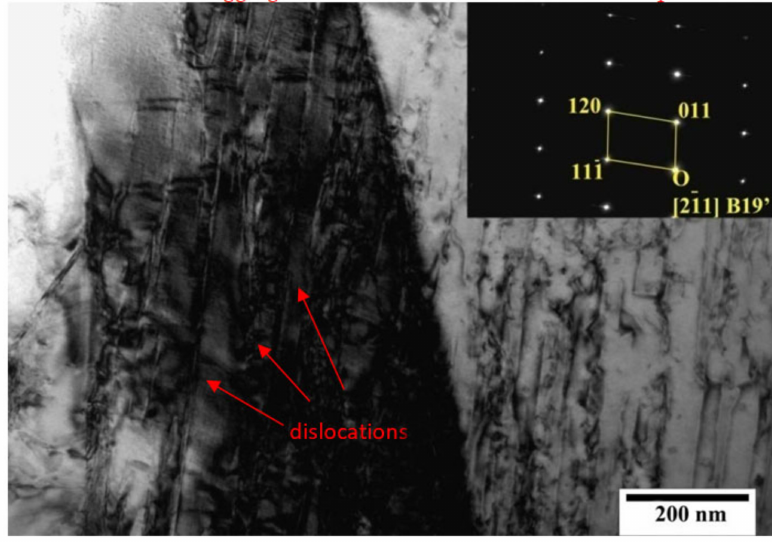
Figure 8. TEM analysis of the 4% compression sample and SAED of the B19’ phase.